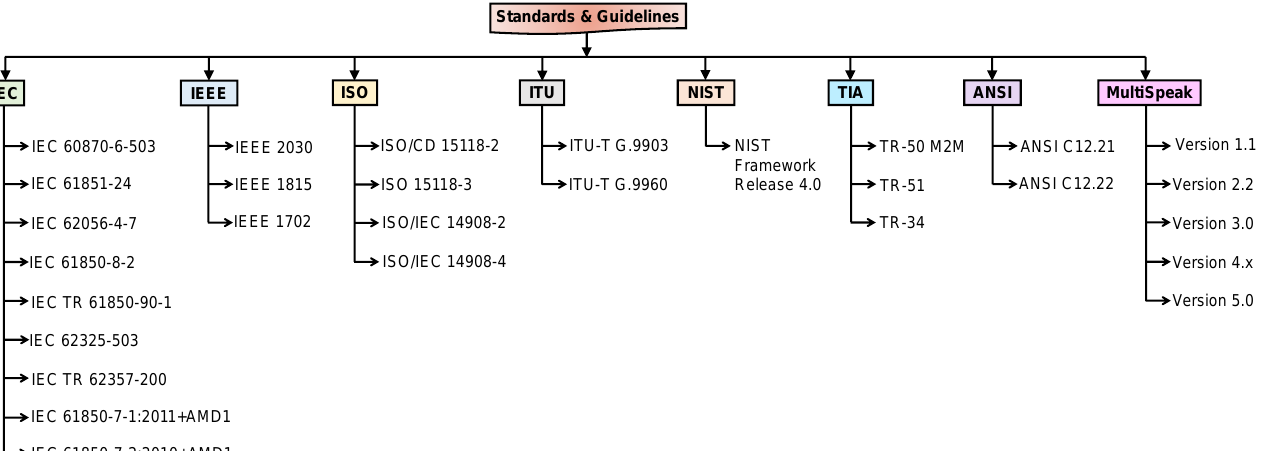
Figure 4. Key standards and technologies for smart microgrid communication.